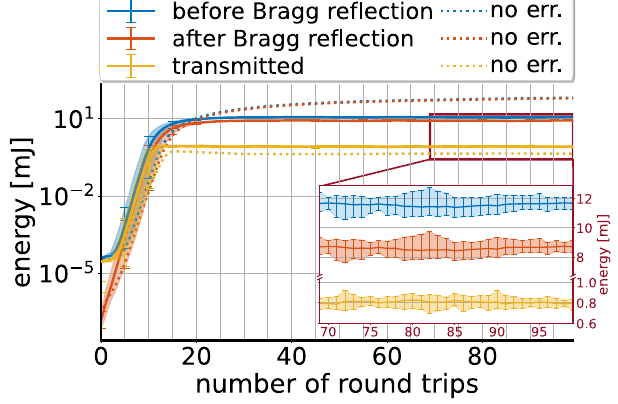
FIG. 3. Evolution of pulse energy for a photon energy of E ¼ 6 . 95 keV. The larger plot shows the full evolution in the c logarithmic scale while the inset shows the pulse energy after saturation in a linear scale. Please note the broken ordinate in the inset to better emphasize the transmitted pulse energy. The data are based on averaging 15 individual runs, with the solid lines representing the ensemble average and the shaded area represent- ing the full range of pulse energies for the specific shot. The dotted lines in the main plot represent the ensemble average of 12 runs without any jitter or tilt error introduced. The blue and orange curves at the first round trips are unrealistically low as they are based on a much reduced bandwidth compared to the full SASE